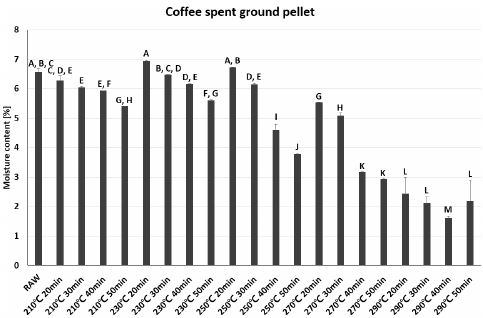
Figure 7. Change in moisture content of each pellet as a function of the process conditions 10 days after the torrefaction experiment.